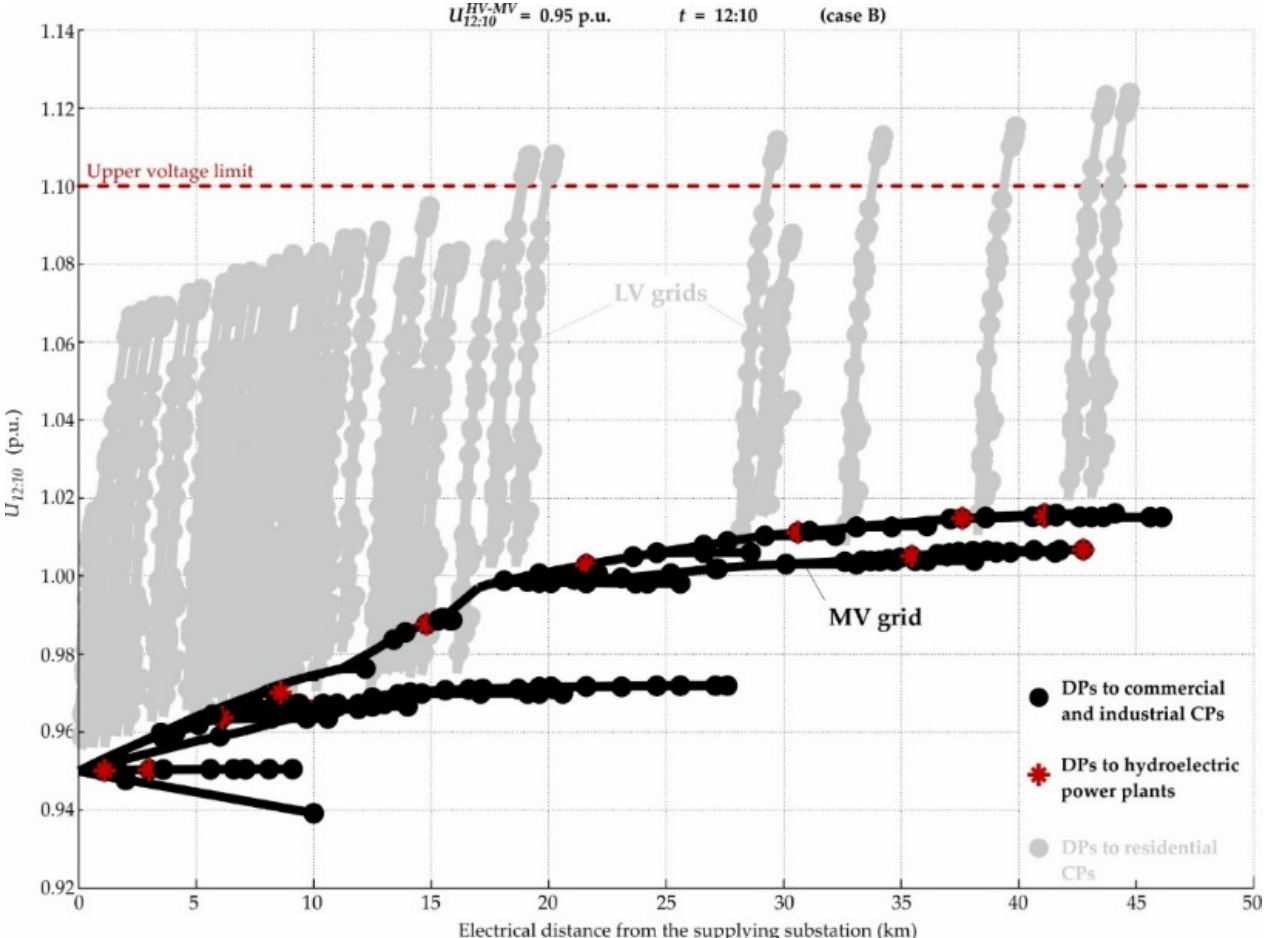
Figure 13. Voltage profiles of the MV and LV grids’ feeders at 12:10 for an HV–MV boundary voltage of 0.95 p.u. (case B).